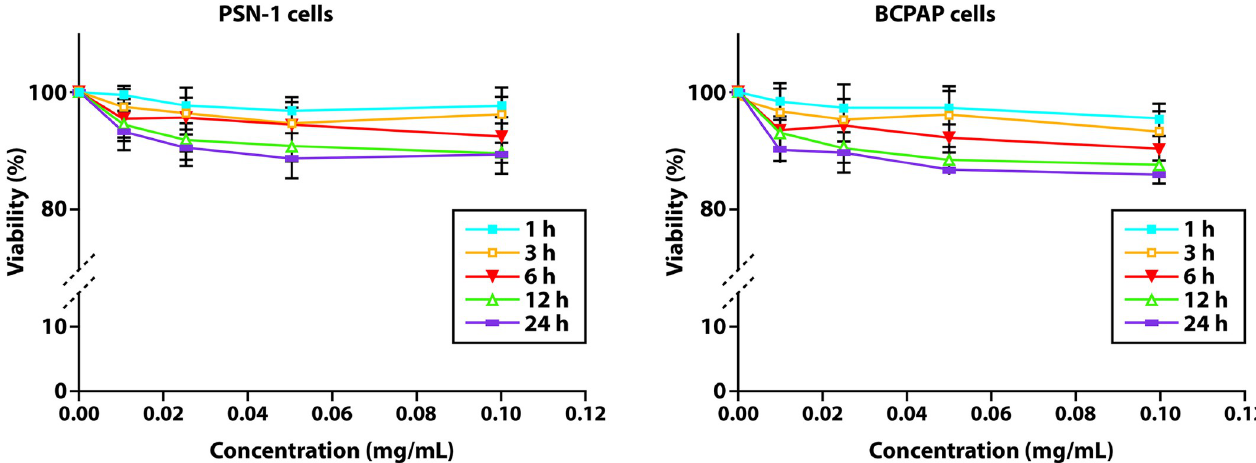
Fig 4. Cytotoxicity in human pancreatic and thyroid cancer cells. Cells (5 � 10 3 � mL -1 ) were treated for 1, 3, 6, 12, and 24 h with increasing concentrations of Glc-SPIONs. Cytotoxicity was assessed by the MTT test. p < 0.05.